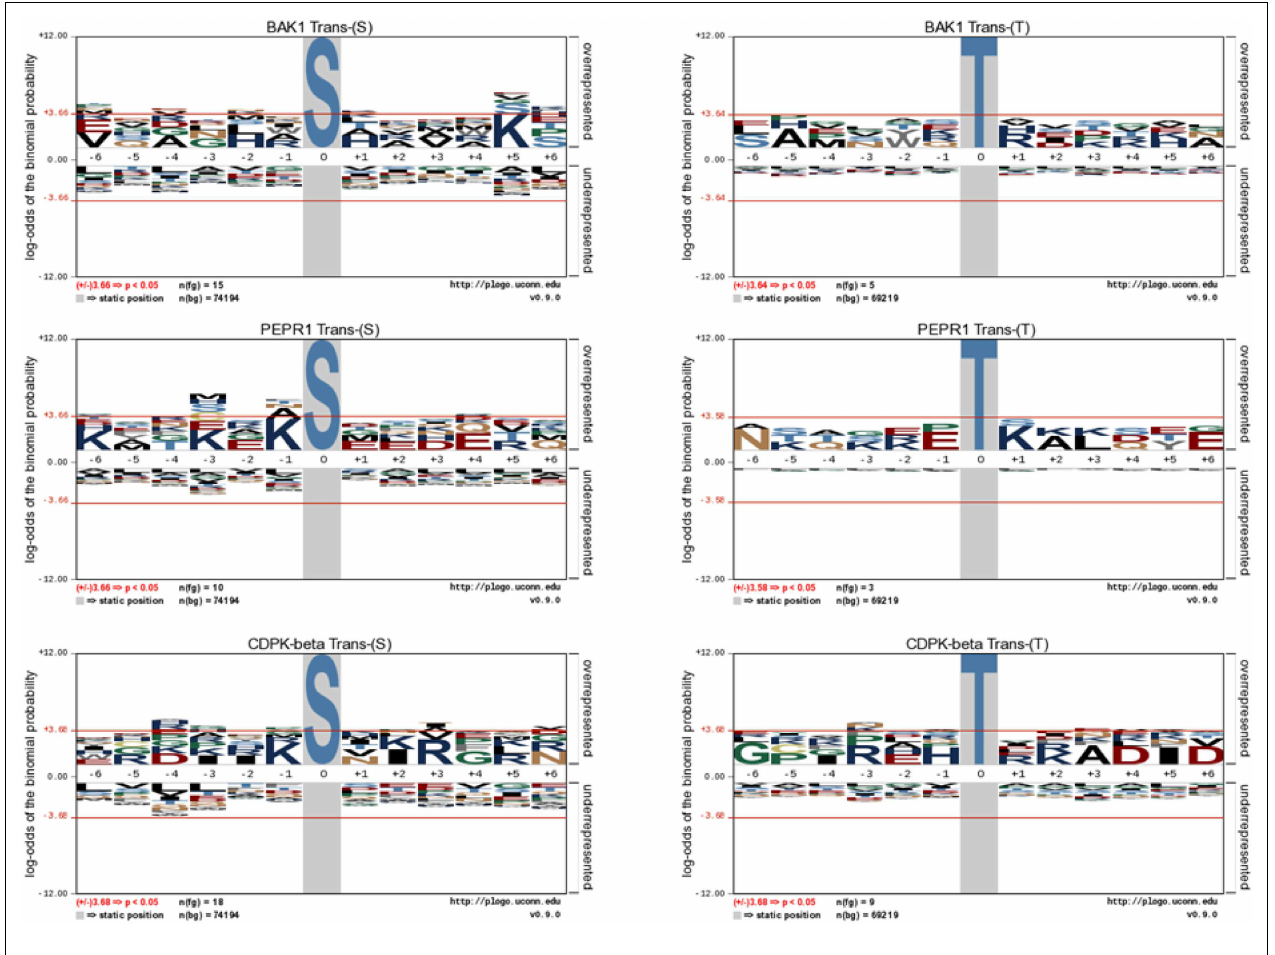
downstream residues are annotated as − 6 to − 1 and + 1 to + 6, respectively. Residues above the x -axis are overrepresented, relative to their statistical significance in the context of the entire E. coli proteome, while residues below the x -axis are underrepresented.The red line corresponds to a p -value of